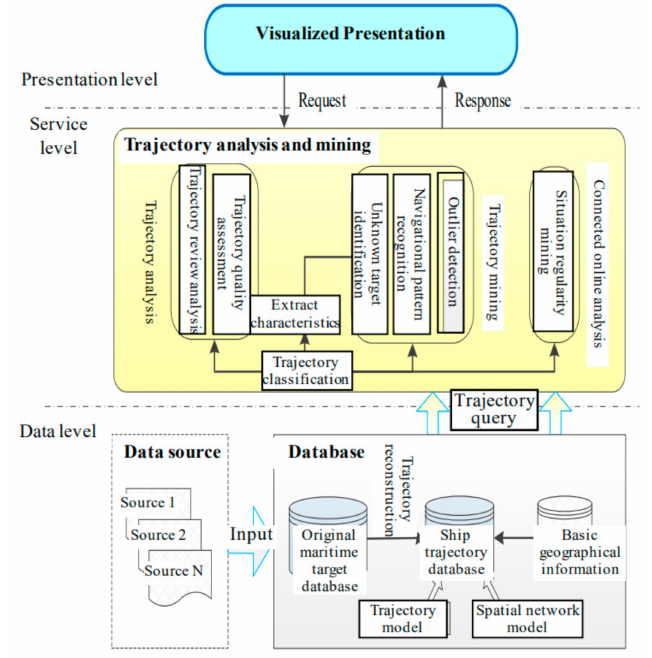
Figure 2. Logical structure diagram of